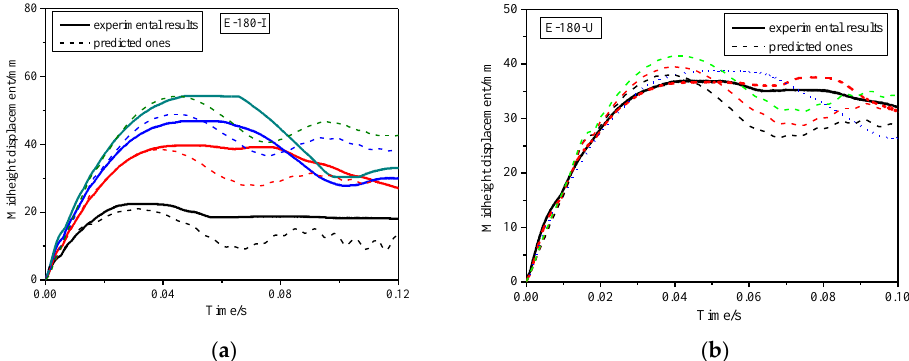
Figure 13. Impact displacement time histories for the specimens ( a ) E-180-I and ( b ) E-180-U.